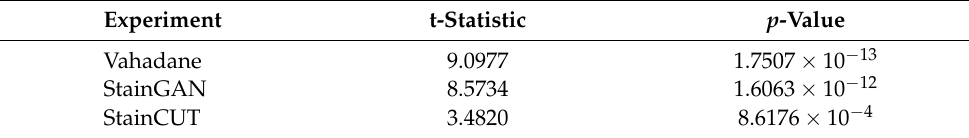
Table A13. Paired t -test to compare Setting (1) to Setting (2) in center UMCU.